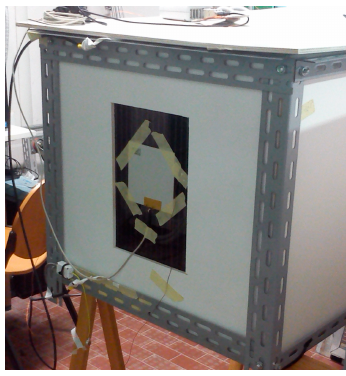
Figure 10. Experimental setup for the laboratory evaluation of U-value of DSM.